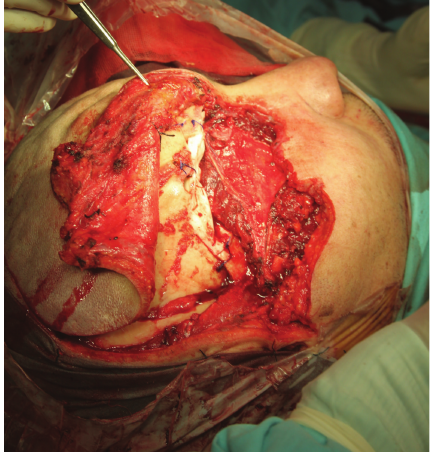
Figure 3: Orbitozygomatic approach. Tumoral resection and reconstruction with